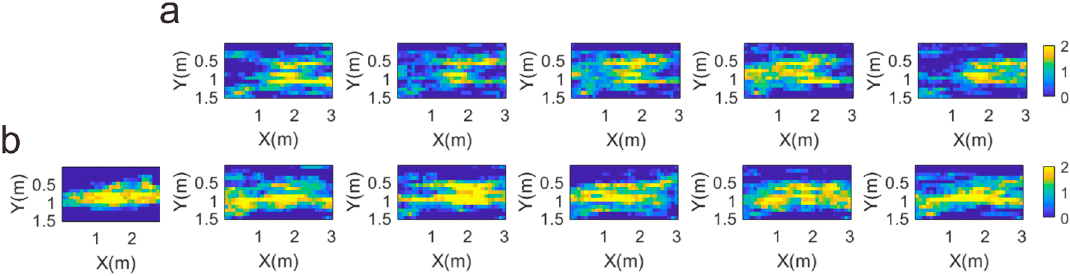
Figure 9. ( a ) Target area of all sampling methods, and ( b ) target area of local sampling methods.